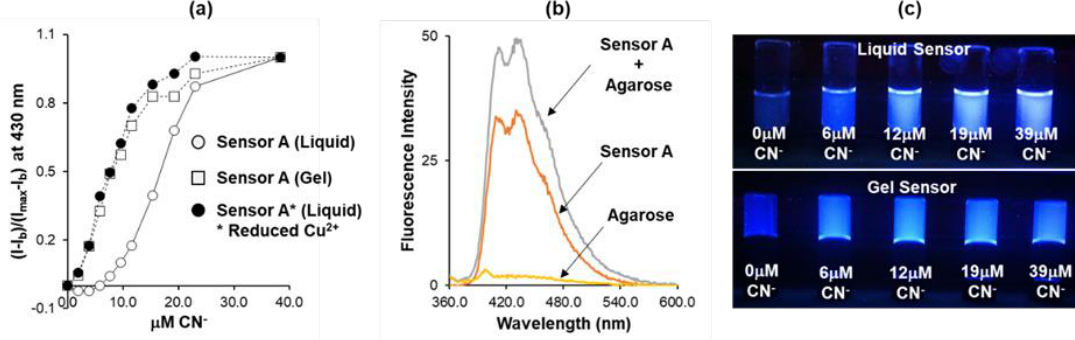
Figure 8. ( a ) Normalized fluorescence recovery of a 0.2 µ M 1 + 0.1 µ M 3 + 4 µ M Cu 2 + liquid Figure 8. (a) Normalized fluorescence recovery of a 0.2  M 1 + 0.1  M 3 + 4  M Cu 2+ liquid mixture mixture (or 0.1 µ M sensor A-liquid ) (open circles), a 0.2 µ M 1 + 0.1 µ M 3 + 4 µ M Cu 2 + + 0.5 wt% (or 0.1  M sensor A-liquid ) (open circles), a 0.2  M 1 + 0.1  M 3 + 4  M Cu 2+ + 0.5 wt% agarose gel agarose gel mixture (or 0.1 µ M sensor A-gel ) (open squares) and a 0.2 µ M 1 + 0.1 µ M 3 + 1.6 µ M mixture (or 0.1  M sensor A-gel ) (open squares) and a 0.2  M 1 + 0.1  M 3 + 1.6  M Cu 2+ liquid mixture Cu 2 + liquid mixture (or 0.1 µ M sensor A - reduced Cu 2 + - liquid ) (filled circles), upon addition of CN − (or 0.1  M sensor A - reduced Cu 2+ - liquid ) (filled circles), upon addition of CN - (  EX = 350 nm). (b) ( λ EX = 350 nm). ( b ) Fluorescence emission spectra ( λ EX = 350 nm; T = 40 ◦ C) of aqueous mixtures Fluorescence emission spectra (  EX = 350 nm; T = 40°C) of aqueous mixtures containing 0.5 wt% containing 0.5 wt% agarose only (yellow curve), 0.2 µ M 1 + 0.1 µ M 3 + 4 µ M Cu 2 + (or 0.1 µ M sensor A ) agarose only (yellow curve), 0.2  M 1 + 0.1  M 3 + 4  M Cu 2+ (or 0.1  M sensor A ) only (orange curve), only (orange curve), and an aqueous mixture containing 0.1 µ M sensor A and 0.5 wt% agarose (grey and an aqueous mixture containing 0.1  M sensor A and 0.5 wt% agarose (grey curve). (c) curve). ( c ) Photographs of CN − -induced fluorescence response of liquid sensor A - reduced Cu 2 + or Photographs of CN - -induced fluorescence response of liquid sensor A - reduced Cu 2+ or sensor A* (top) sensor A* (top) and gel-immobilized sensor A (bottom) taken under UV illumination ( λ EX = 350 nm); and gel-immobilized sensor A (bottom) taken under UV illumination (  EX = 350 nm); vial inversion vial inversion demonstrates demonstrates gel-immobilization.